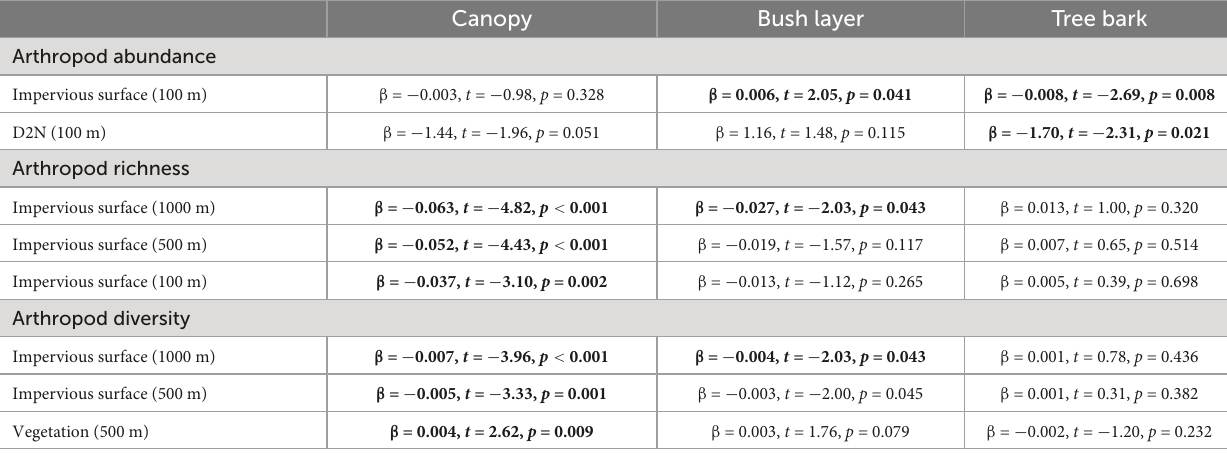
TABLE 1B Association between arthropod abundance (log-transformed), richness, or diversity (Shannon diversity index), and the level of urbanisation per micro-habitat (i.e., canopy, bush layer and tree bark). Canopy Bush layer Tree bark